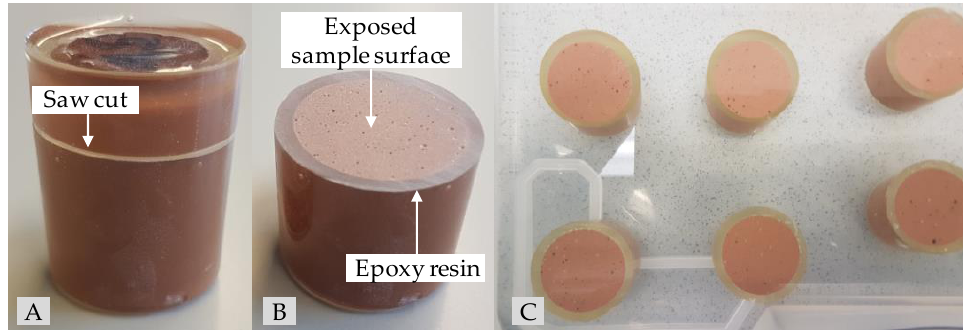
Figure 1. Epoxy-embedded geopolymer specimen for sulfuric acid exposure before ( A ) and after saw cut ( B ) as well as geopolymers GP7.5 (( C ), top row) and GP9.0 (( C ), lower row) after one day in sulfuric acid (pH 1).